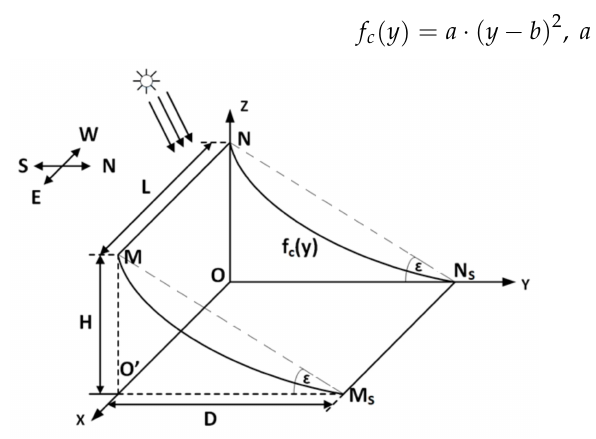
Figure 1. Concave parabolic